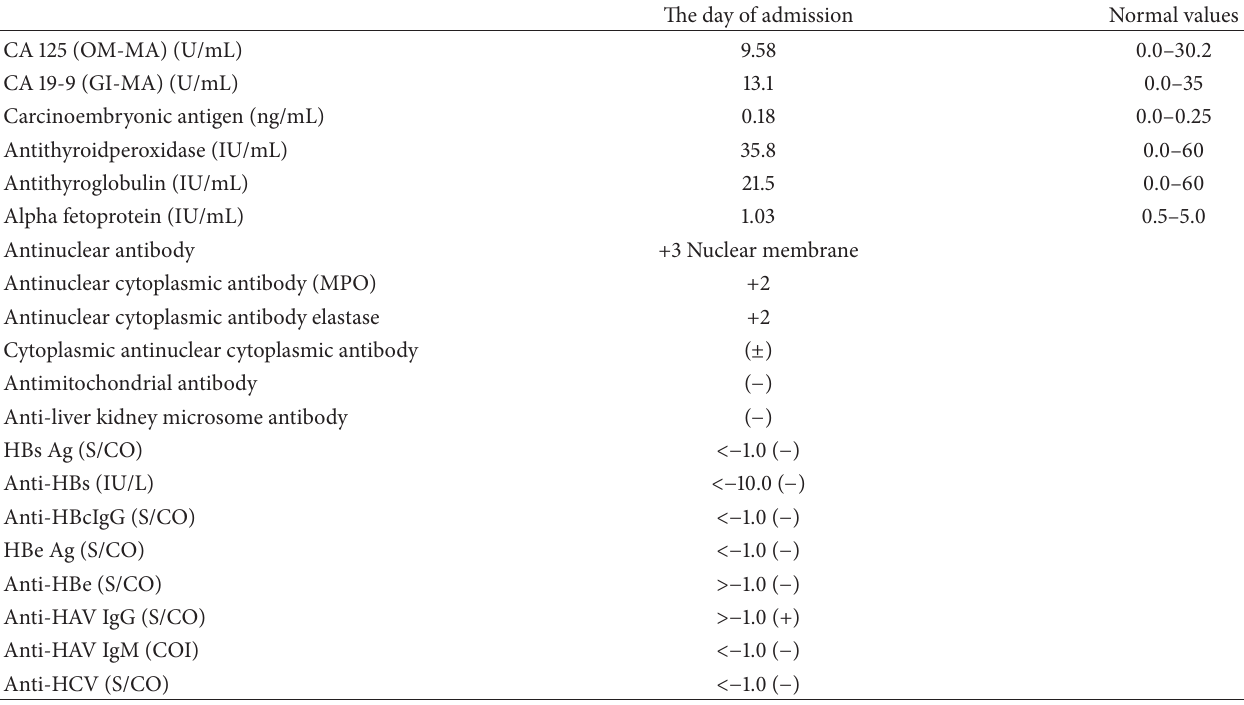
Table 2: Immunologic parameters of the case.